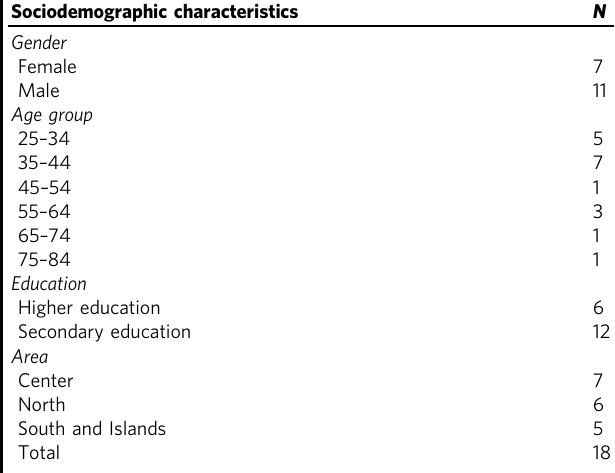
Table 1 Sociodemographic data on the